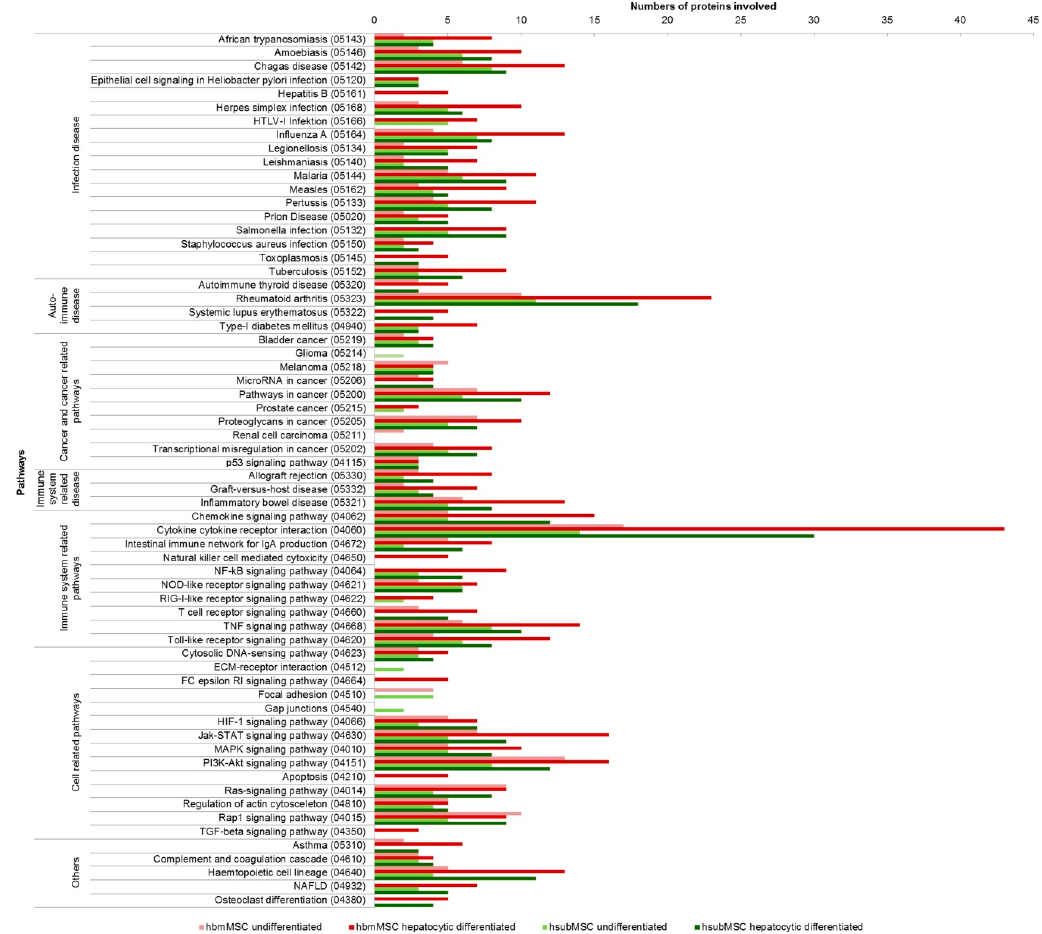
Figure 5. Pathway analysis of proteins secreted by hbmMSC ( red ) and hsubMSC ( green ) before ( light colours) and after ( dark colours) hepatocytic differentiation. Pathways were identified using the Search Tool for the Retrieval of Interacting Genes/Proteins (STRING) database (pathway identifiers given in parentheses) and clustered into main disease- or cellular processes-related pathways ( Y -axis). The number of proteins involved in each single pathway is depicted on the X -axis. All pathways shown were significant at the p < 0.05 level as calculated from three independent array analyses for each cell type before and after differentiation. Table 1. Pathway analysis by the David database of high abundance analytes secreted by undifferentiated hbmMSC and hsubMSC (taken from Tables S1 and S2). Associated KEGG-pathways with p -values of significance as well as analytes involved and “not found” are shown, respectively.